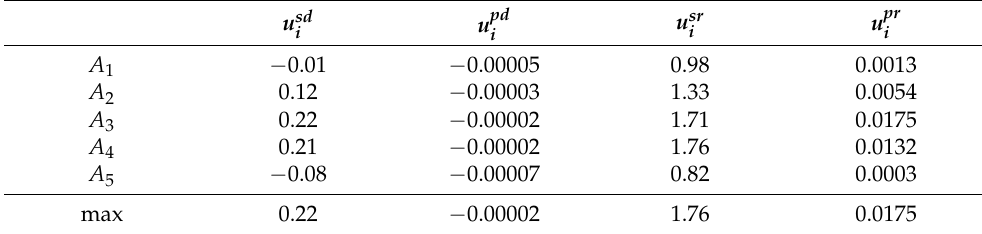
Table 18. The values of four utility measures.